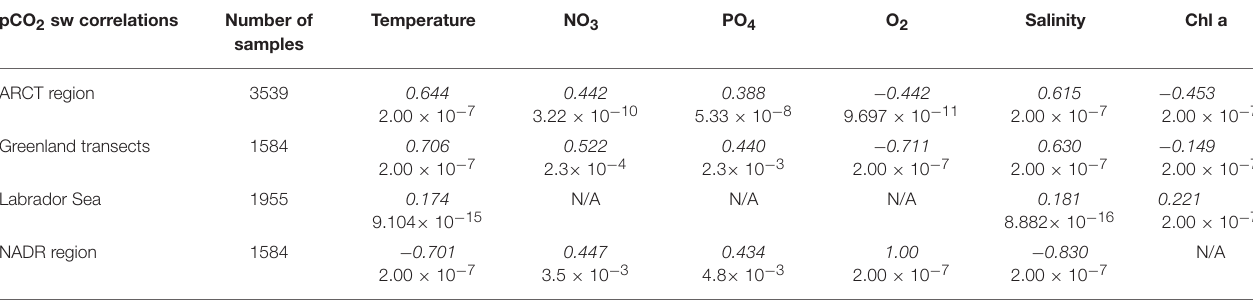
TABLE 4 | Significant spearman correlation coefficients between pCO 2 and the variable listed in the top of the table. pCO 2 sw